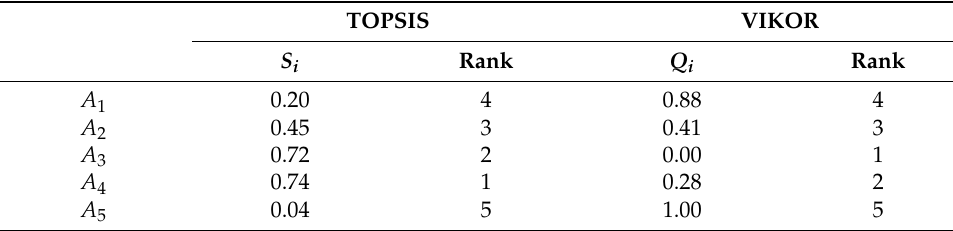
Table 16. The ranking results obtained by using TOPSIS and VIKOR